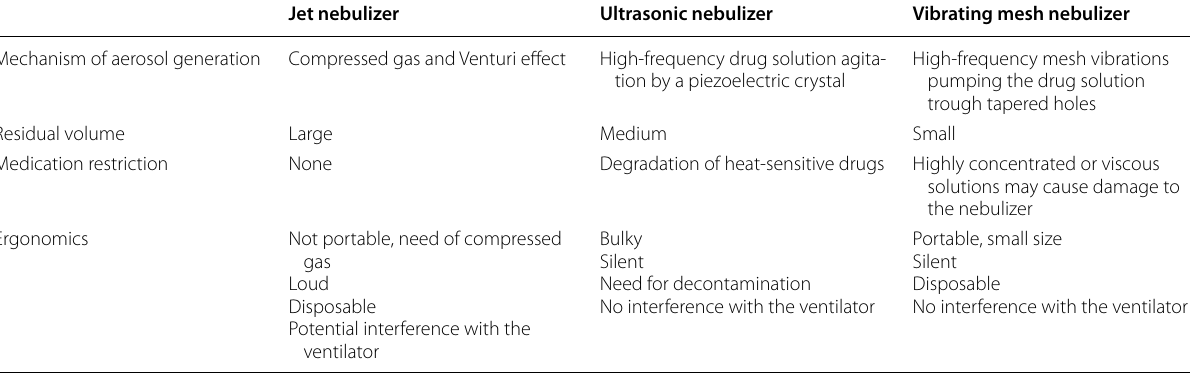
The particle sizes generated depend on each individual nebulizer model rather than the nebulizer type, and they are substantially impacted by the measurement conditions (e.g., temperature and humidity). For example, some specific jet nebulizers may deliver large particles (>5 µm for proximal targeting), whereas others deliver nanoparticles. All nebulizers available for clinical use produce sufficient droplets in the 1–5 µm size range of for pulmonary delivery during mechanical